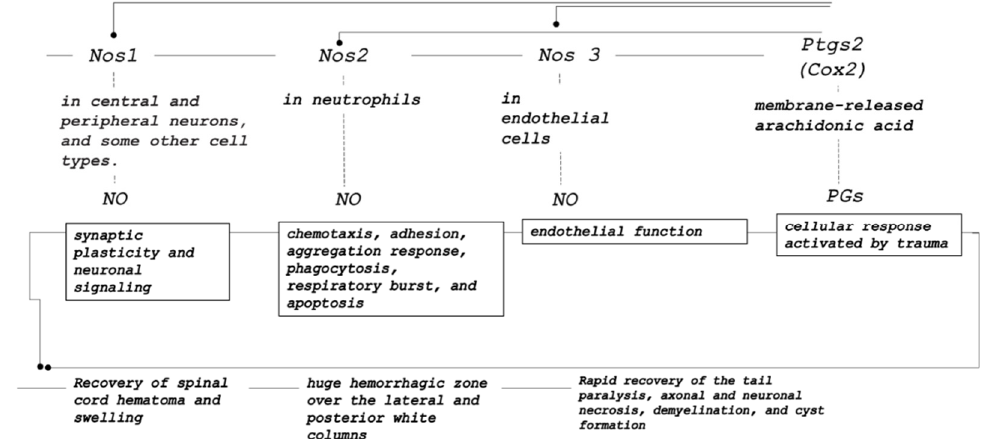
Figure 16. Illustration of the effects obtained in mRNA studies as the molecular background of the rapid efficacy of the BPC 157 therapy. We indicated that BPC 157 therapy should be specifically related to the NO system (increased Nos 1 , Nos 2 , Nos3 ) and prostaglandins system (increased Ptgs2 ( Cox 2 )) pathways, since Akt1 , VEGFa , Mtor , Prkcg , and Pkt2 were not affected by BPC 157 therapy. In BPC 157 rats, the increase in Nos 1 , Nos 2 , and Nos3 meant the synergistically increased capability of synaptic plasticity and neural signaling ( Nos1 ), increased neutrophils function (i.e., chemotaxis, adhesion, aggregation response, phagocytosis), and endothelial function ( Nos 3 ), synergistically affecting the prostaglandin system ( Cox 2 ), and the cellular response activated by trauma. Together, these effects might be responsible for the rapid therapy effect in the spinal cord-injured rats.